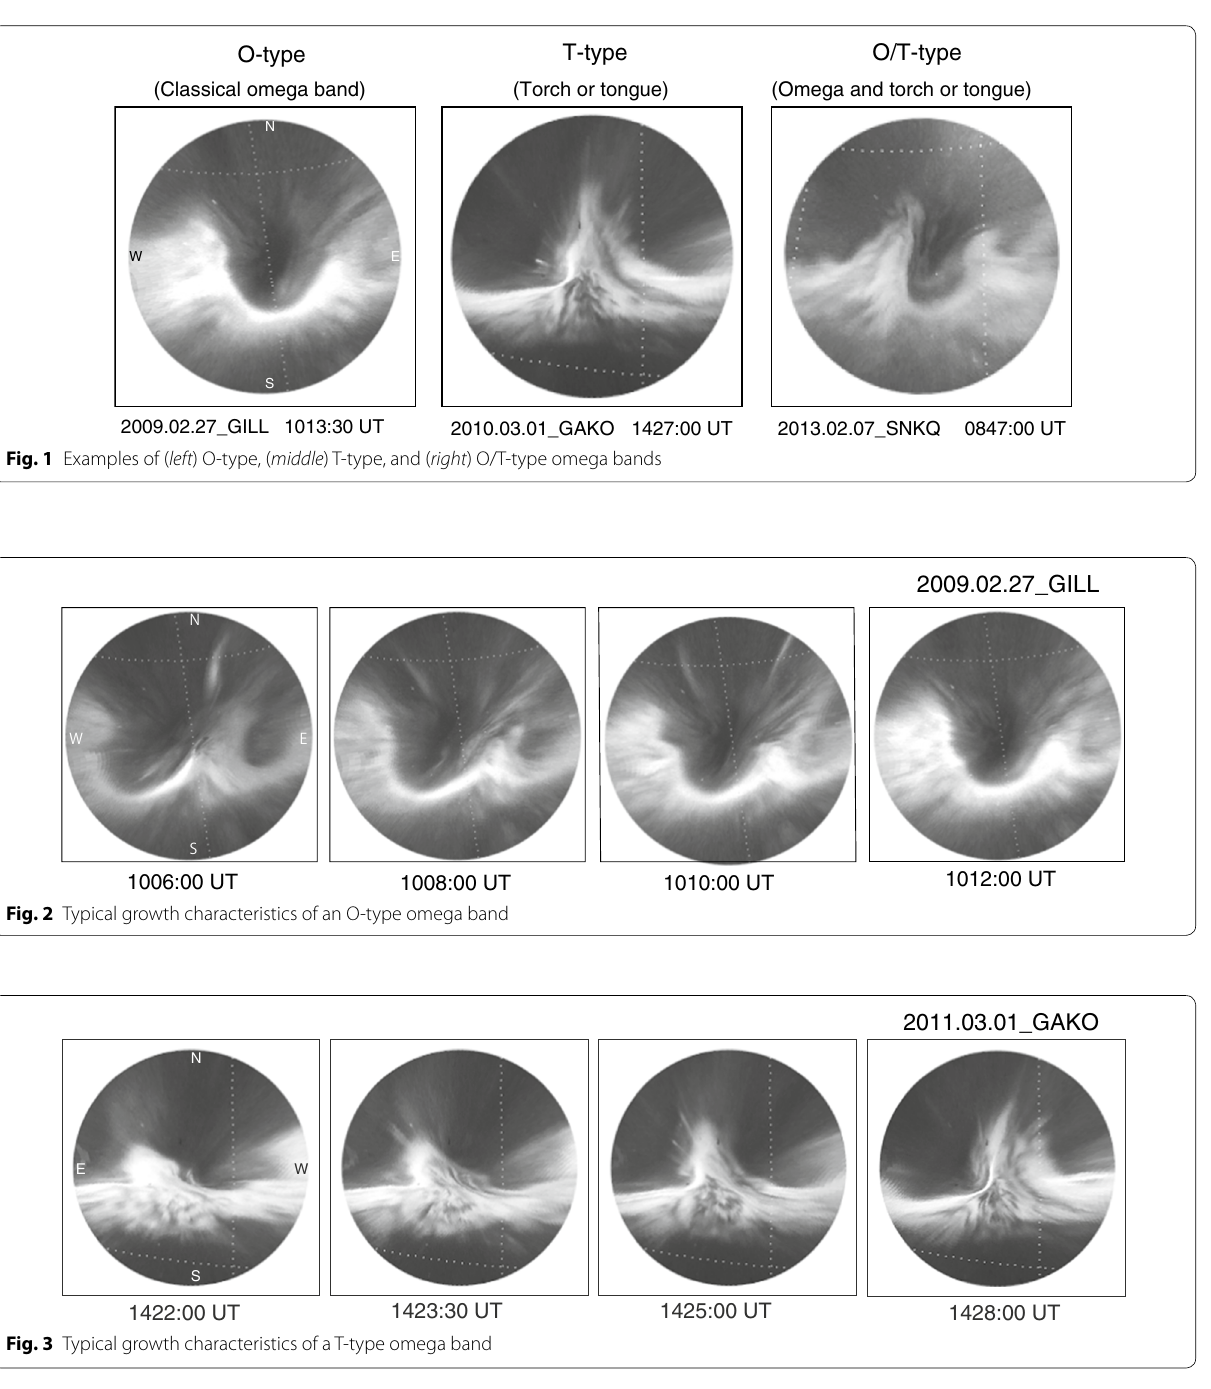
omega band aurora formation. The 3-s-resolution movie corresponding to this event revealed an intense, pulsating aurora consistent with the inside of a torch aurora. An additional movie file shows this in more detail (see Addi- tional file 2: Movie S2).